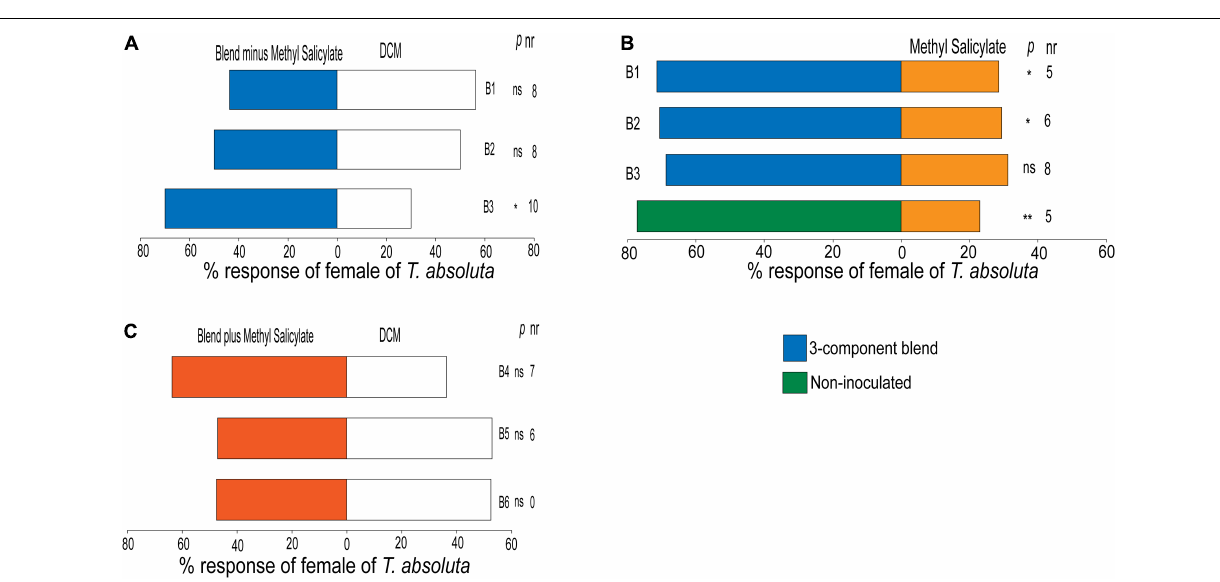
FIGURE 6 | Behavioral responses of females of Tuta absoluta to (A) the three-component blend consisting of the most attractive compounds, α -pinene, 2-carene, β -phellandrene, all against DCM, dichloromethane (control solvent). (B) % responses of females of T. absoluta to three-component blend and non-inoculated tomato plant all against methyl salicylate (positive control). (C) % responses of females of T. absoluta to the four-component blend containing α -pinene, 2-carene, β -phellandrene, and methyl salicylate in a Y-tube olfactometer. nr, number of non-respondent insects (i.e., no choice). P stands for statistical significance levels with ns, no significant difference ( P > 0.05); *, **, significant differences at P < 0.05; and P < 0.01, respectively, from χ 2 test at α =